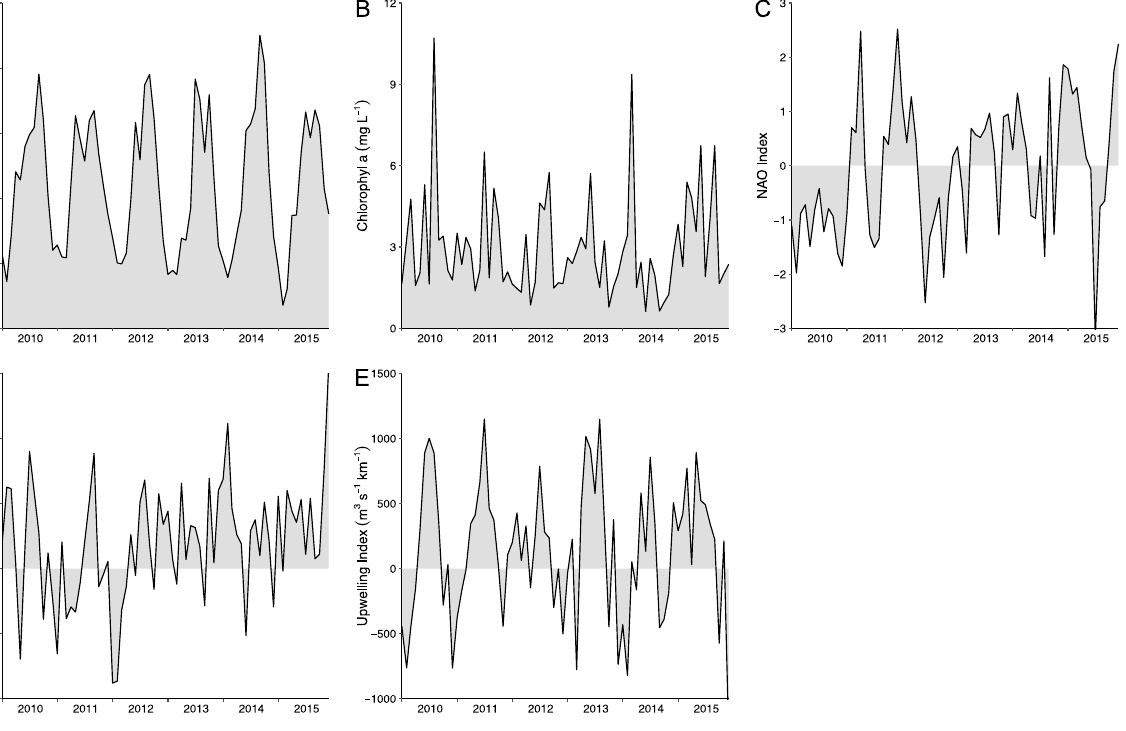
Figure 3. Monthly values for the selected environmental factors in the Portuguese Atlantic coast (2010–2015): ( A ) Sea Surface Temperature (SST; °C); ( B ) Chlorophyll a (Chla; mg L −1 ); ( C ) North Atlantic Oscillation index (NAO); ( D ) East Atlantic Pattern (EA); ( E ) Upwelling index (Ui; m 3 s −1 km −1